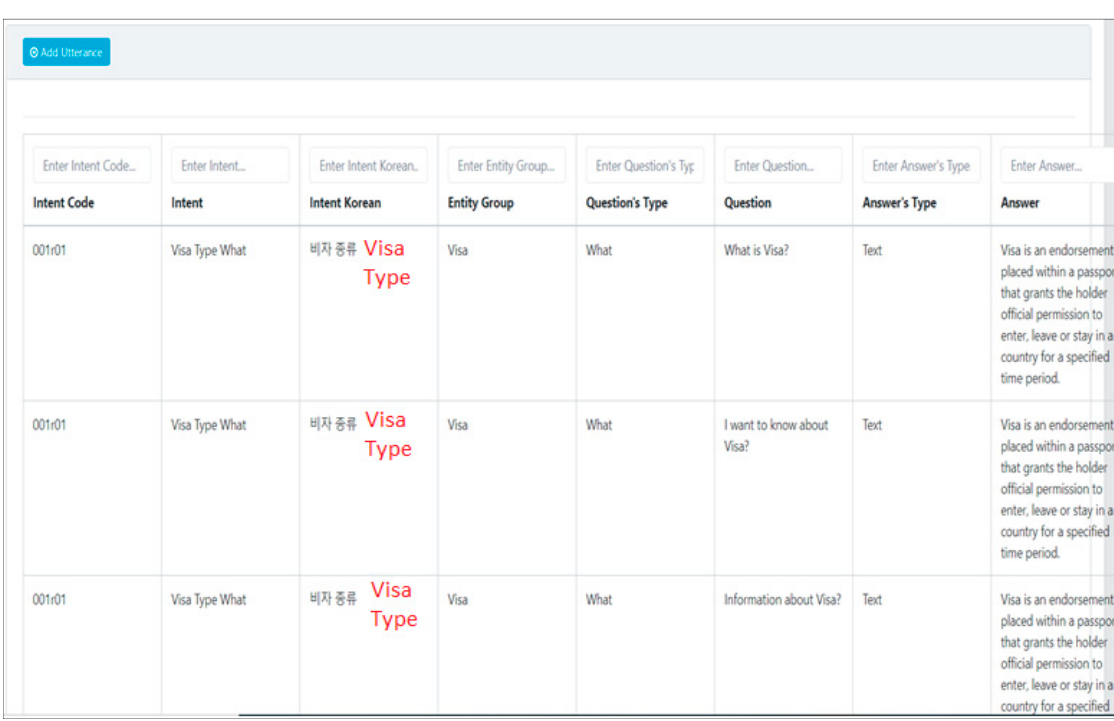
Figure 16. Data set sample of Utterance.